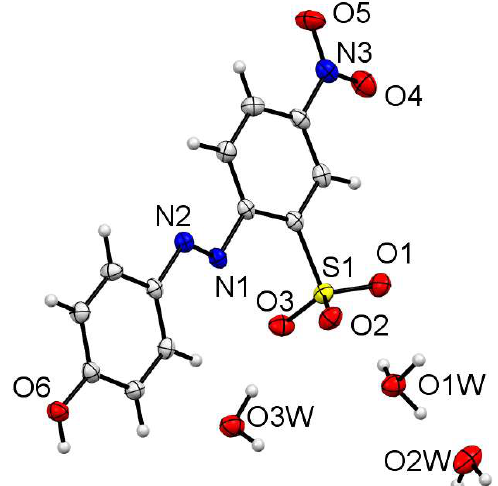
Figure 4. Contents of the asymmetric unit of free acid species H18 . Note protonation at the aromatic N atom, N3.